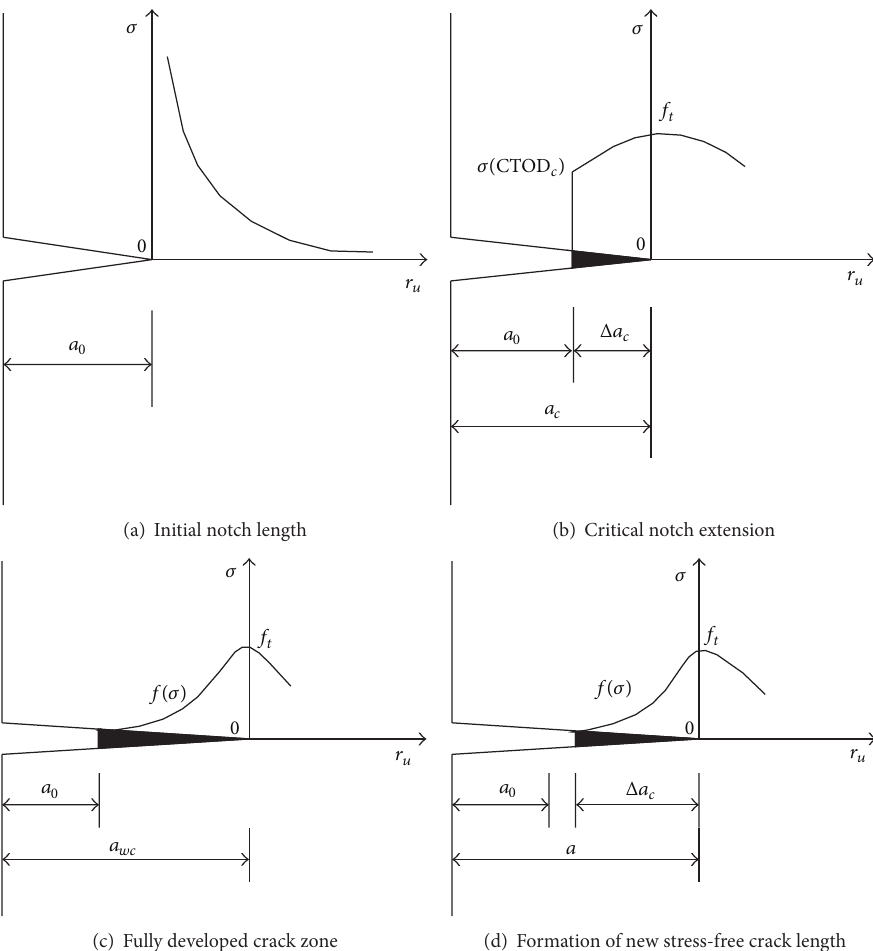
Figure 1: Four stages of crack propagation during the fracture